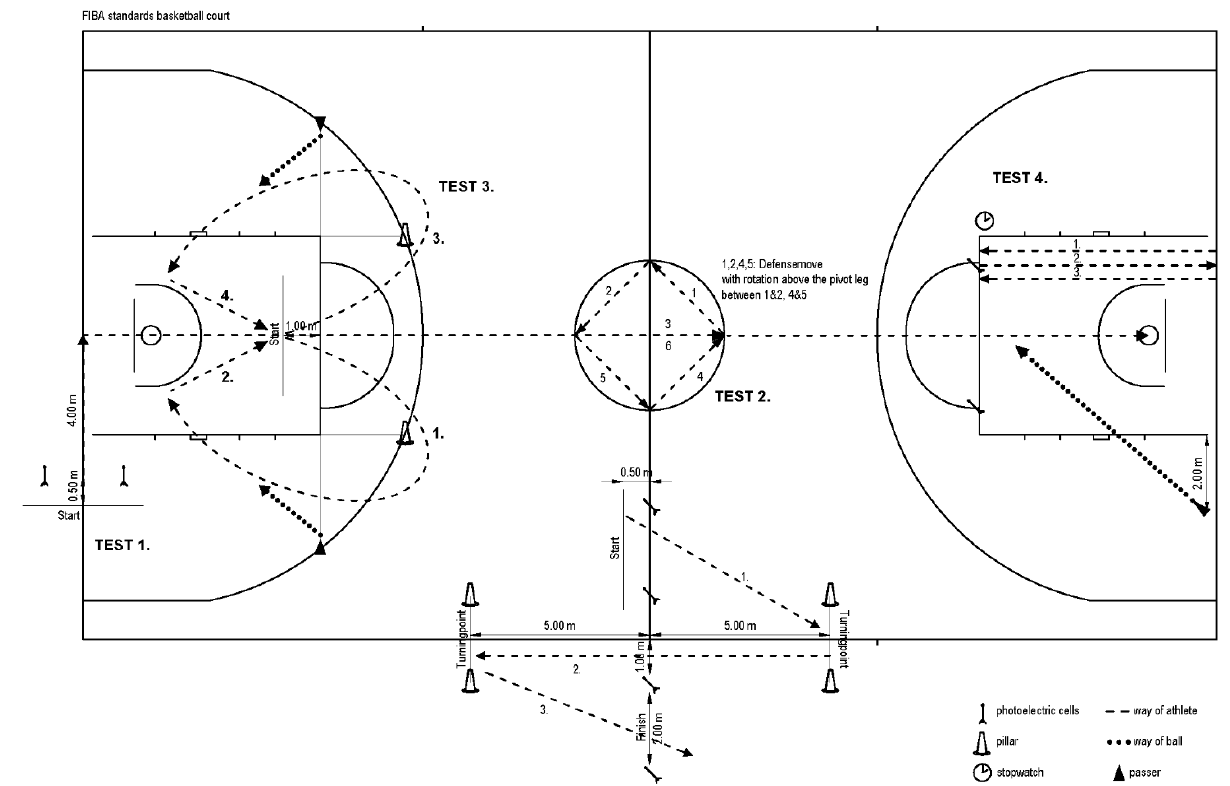
Figure 2. Basketball Specific Complex Test (BBCT) Test 1: 20 m sprint with two changes of direction after 5 m and 15 m with and without the ball. (green runway); Test 2: Fast break with a bounce pass and lay-up (red runway); Test 3: Lay-up parcours, consisting of a throw pass while running (orange runway); Test 4: Brick test — a sprint endurance test consisting of side steps and sprints without the ball (blue runway); adapted and edited from [28] .